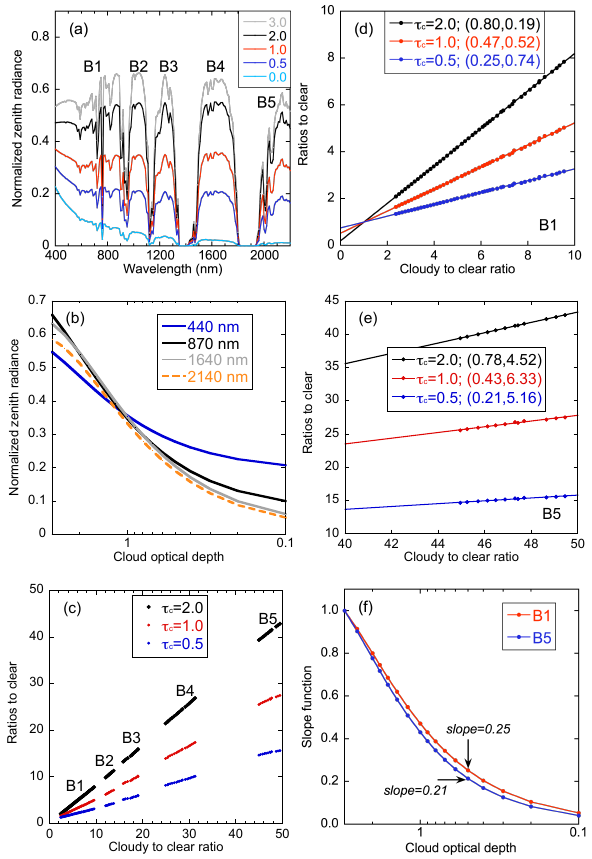
Figure 1. SBDART simulations from the control run. (a) Simulated zenith radiance at cloud 5 Fig. 1. SBDART simulations from the control run. (a) Simulated optical depths ( τ c ) ranging from 0 to 3. Wavelength bands are defined in Table 2. (b) Zenith 6 zenith radiance at cloud optical depths ( τ c ) ranging from 0 to 3. radiances as a function of cloud optical depth at 440, 870, 1640 and 2140 nm wavelengths. (c) 7 Wavelength bands are defined in Table 2. (b) Zenith radiances as a function of cloud optical depth at 440, 870, 1640 and 2140nm wavelengths. (c) Plot of radiance ratios to clear ( y -variable in Eq. 4) vs. “cloudy to clear ratio” (i.e., x -variable in Eq. 4) at τ c = 2 . 0, 1.0 and 0.5. Values at water vapor absorption bands are excluded in the plot to avoid division smaller numbers. Zoom-in plots at wave- length band B1 and B5 are shown in (d) and (e) , respectively. Data points are connected by linear regression lines; the corresponding slope and intercept of the line are listed in parenthesis. By extend- ing the same analyses to more cloud optical depth in the transition zone, a slope function can be derived and is plotted in (f) for bands B1 and B5.